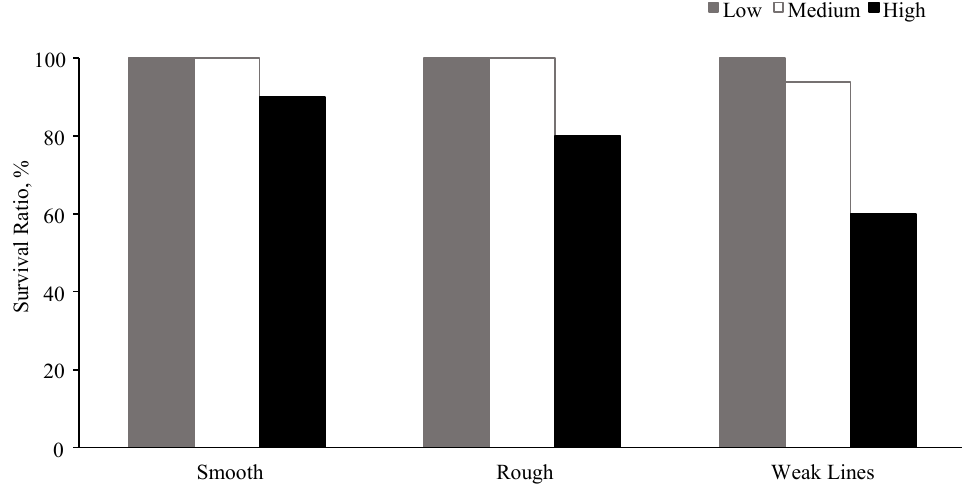
Figure 8. Survival ratio of capsules with various surface types at different level of mixing speed.